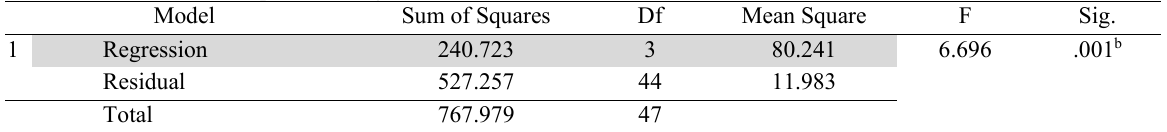
The ANOVA test for multiple linear regression test results Model